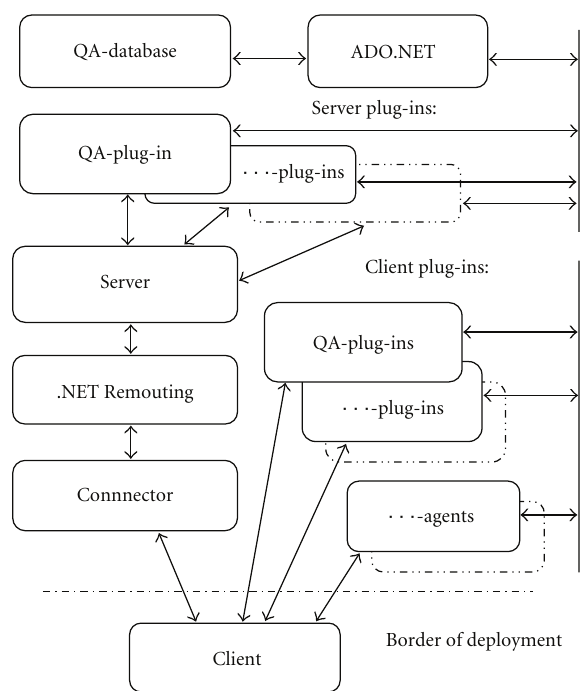
Figure 7: Component structure of the WIQA.Net.